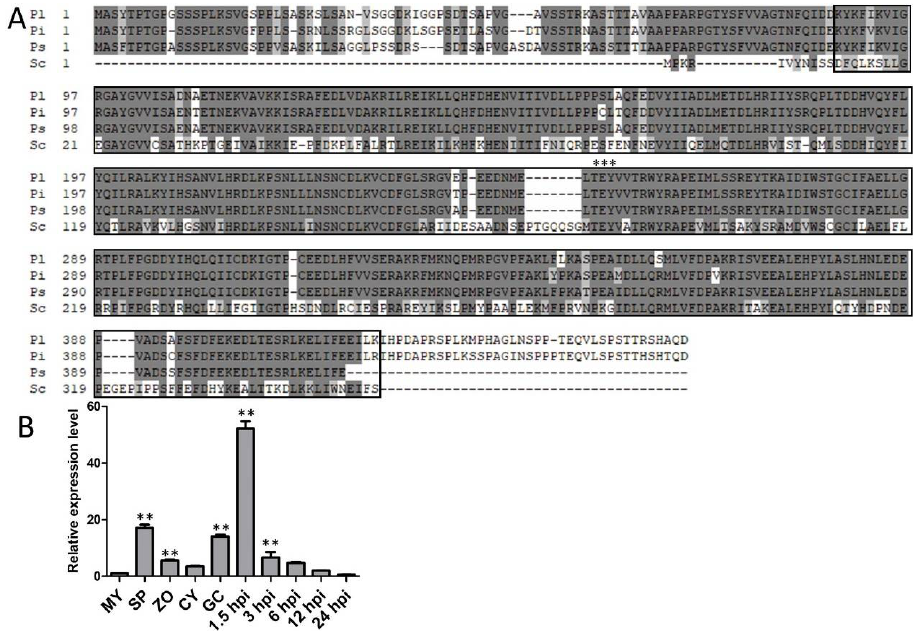
Figure 1. Identification of PlMAPK2 in P. litchii . ( A ) Amino acid sequences alignment of PlMAPK2 (Pl) and its orthologs from P. infestans (Pi), P. sojae (Ps) and S. cerevisiae (Sc). The black boxes and three black asterisks represent catalytic domain of the serine/threonine kinase and conserved TEY motif, respectively. ( B ) Expression pattern of PlMAPK2 during the asexual life cycle and infection stages was analyzed by quantitative reverse transcription PCR (qRT-PCR). MY: Mycelia; SP: sporangia; ZO: zoospore; CY: cyst; GC: germination of cyst; hpi: hours post inoculation. Relative expression levels were calculated using the MY values as reference. Asterisks indicate significant difference (** p < 0.01) based on Bonferroni’s multiple comparison test. These experiments were repeated three times.